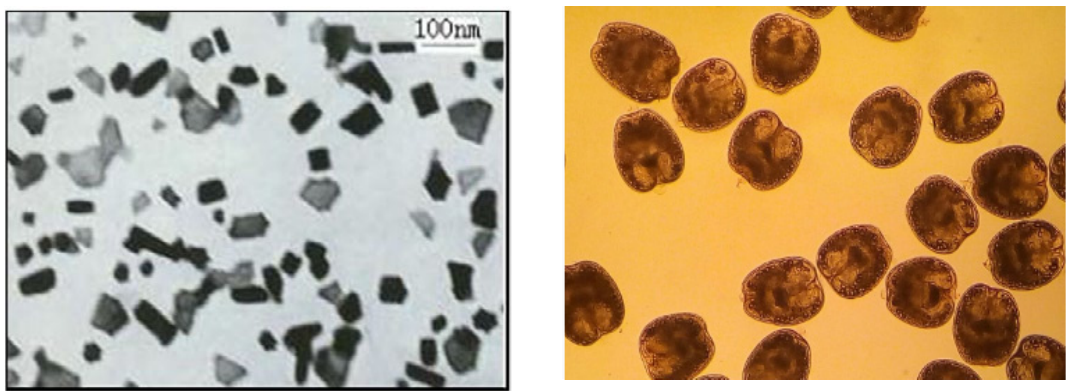
Fig. 2. Image of live protoscolices Fig. 1. The TEM image of 15 nm ZnO NPs Table 1. Scolicidal effect of ZnO NPs at the 50 mg/ml concentration following various exposure times Exposure time(min) Experiments